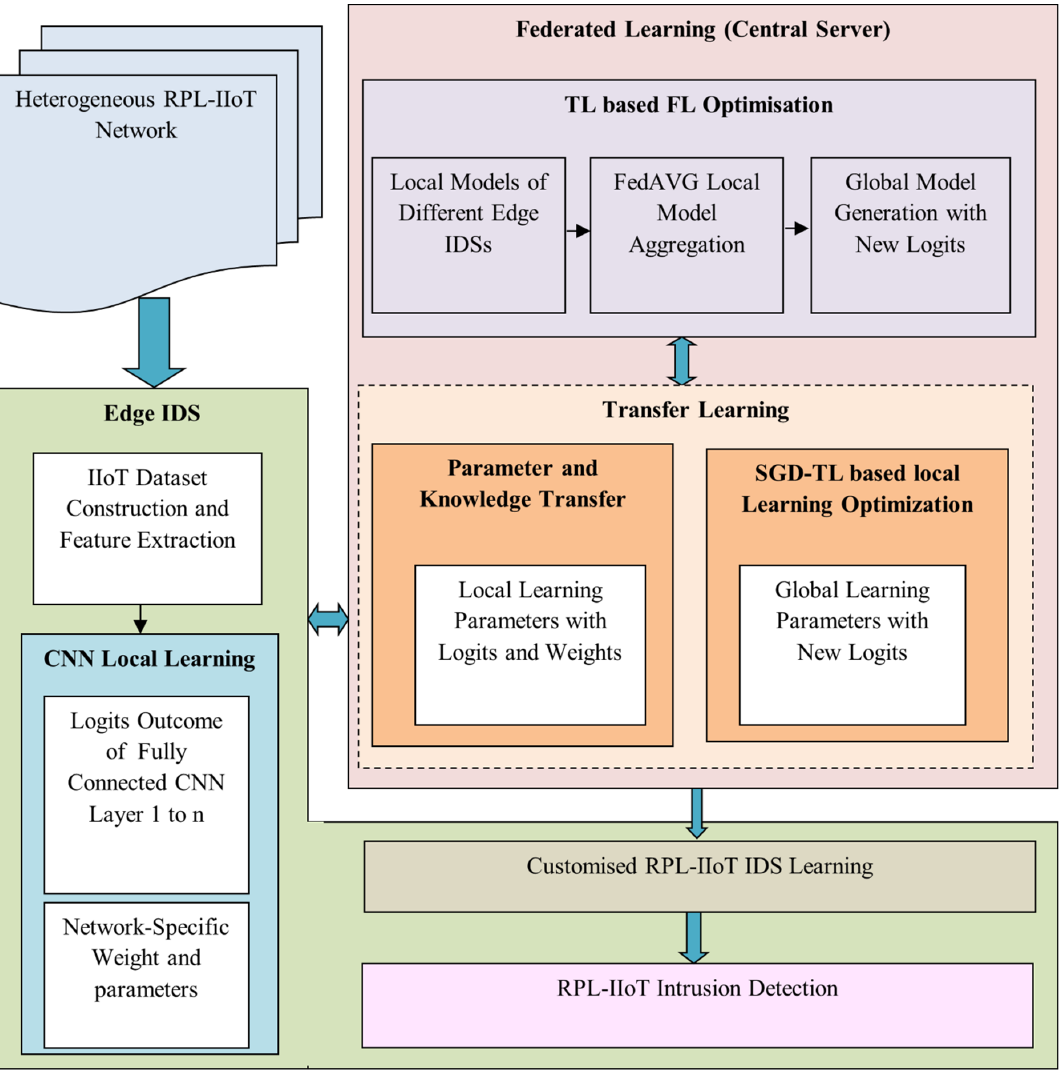
Figure 2. Overview of the design of the proposed FT-CID model.